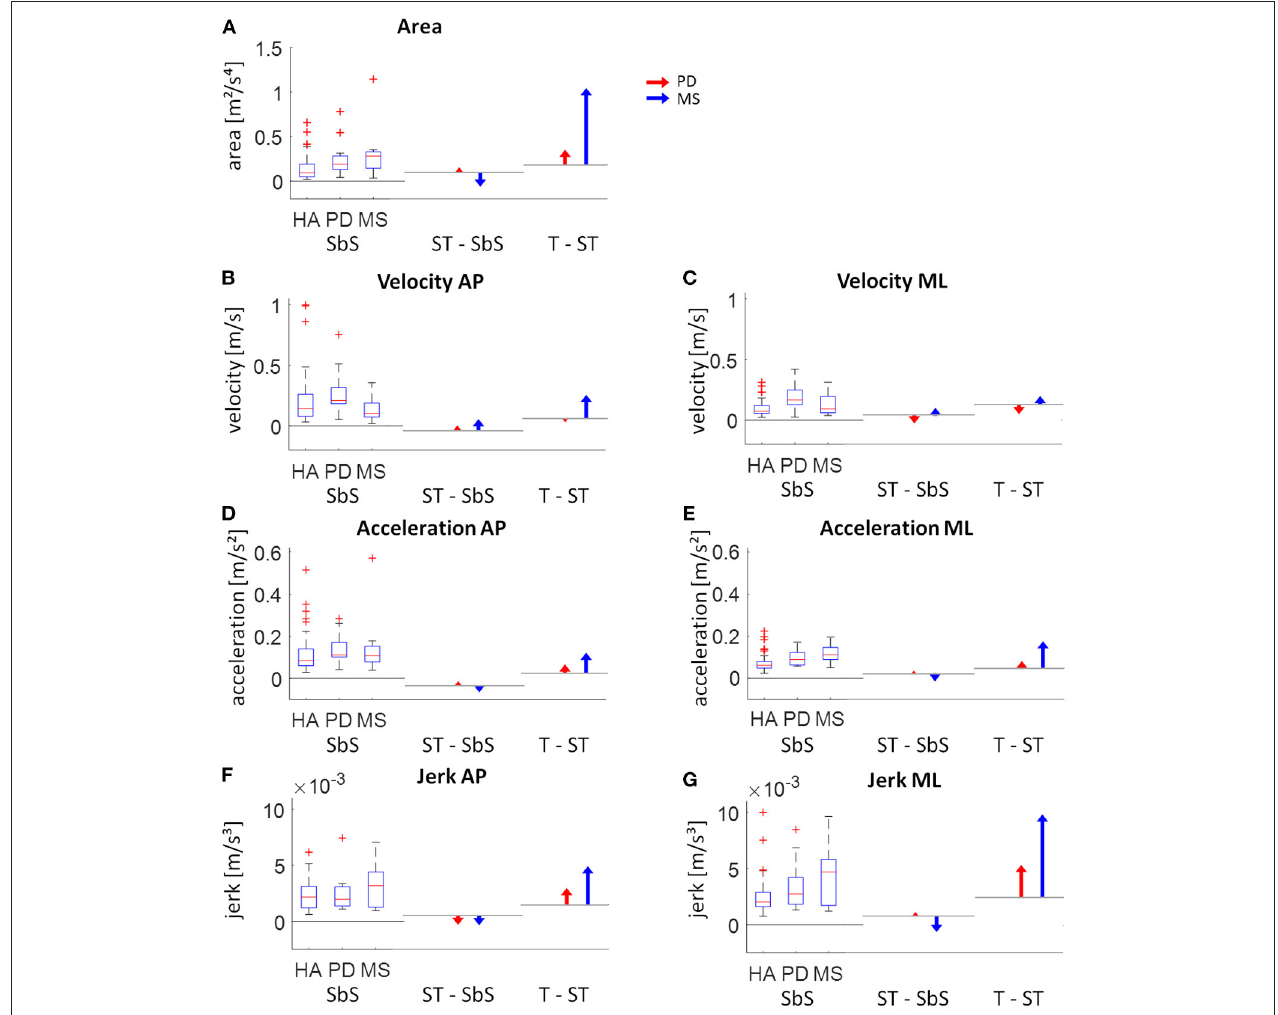
FIGURE 4 | Visual presentation of the intra-group changes of respective static sway parameters. The left part of each graph shows the absolute values for side-by-side (SbS) stance (with boxplots showing the median, upper and lower quartiles, the 1.5 interquartile range and the outliers). The middle and right part of each graph show the age-corrected differences relative to the healthy adults (HA) between SbS and semi-tandem stance (ST - SbS) and between ST and tandem stance (T - ST) for the Parkinson patients (PD; red) and multiple sclerosis patients (MS; blue). The horizontal lines indicate the change in sway for the healthy adults between the tasks (calculated by subtracting the quadratic fits from each assessment). (A) sway area, (B) velocity in antero-posterior (AP) direction, (C) velocity in medio-lateral (ML) direction, (D) acceleration in AP direction, (E) acceleration in ML direction, (F) jerk in AP direction and (G) jerk in ML